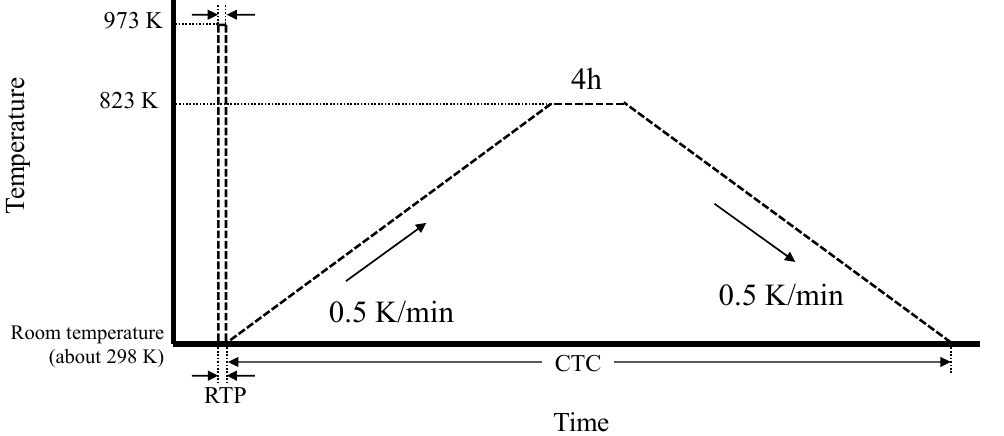
Figure 2. Temperature program of RTP and CTC.